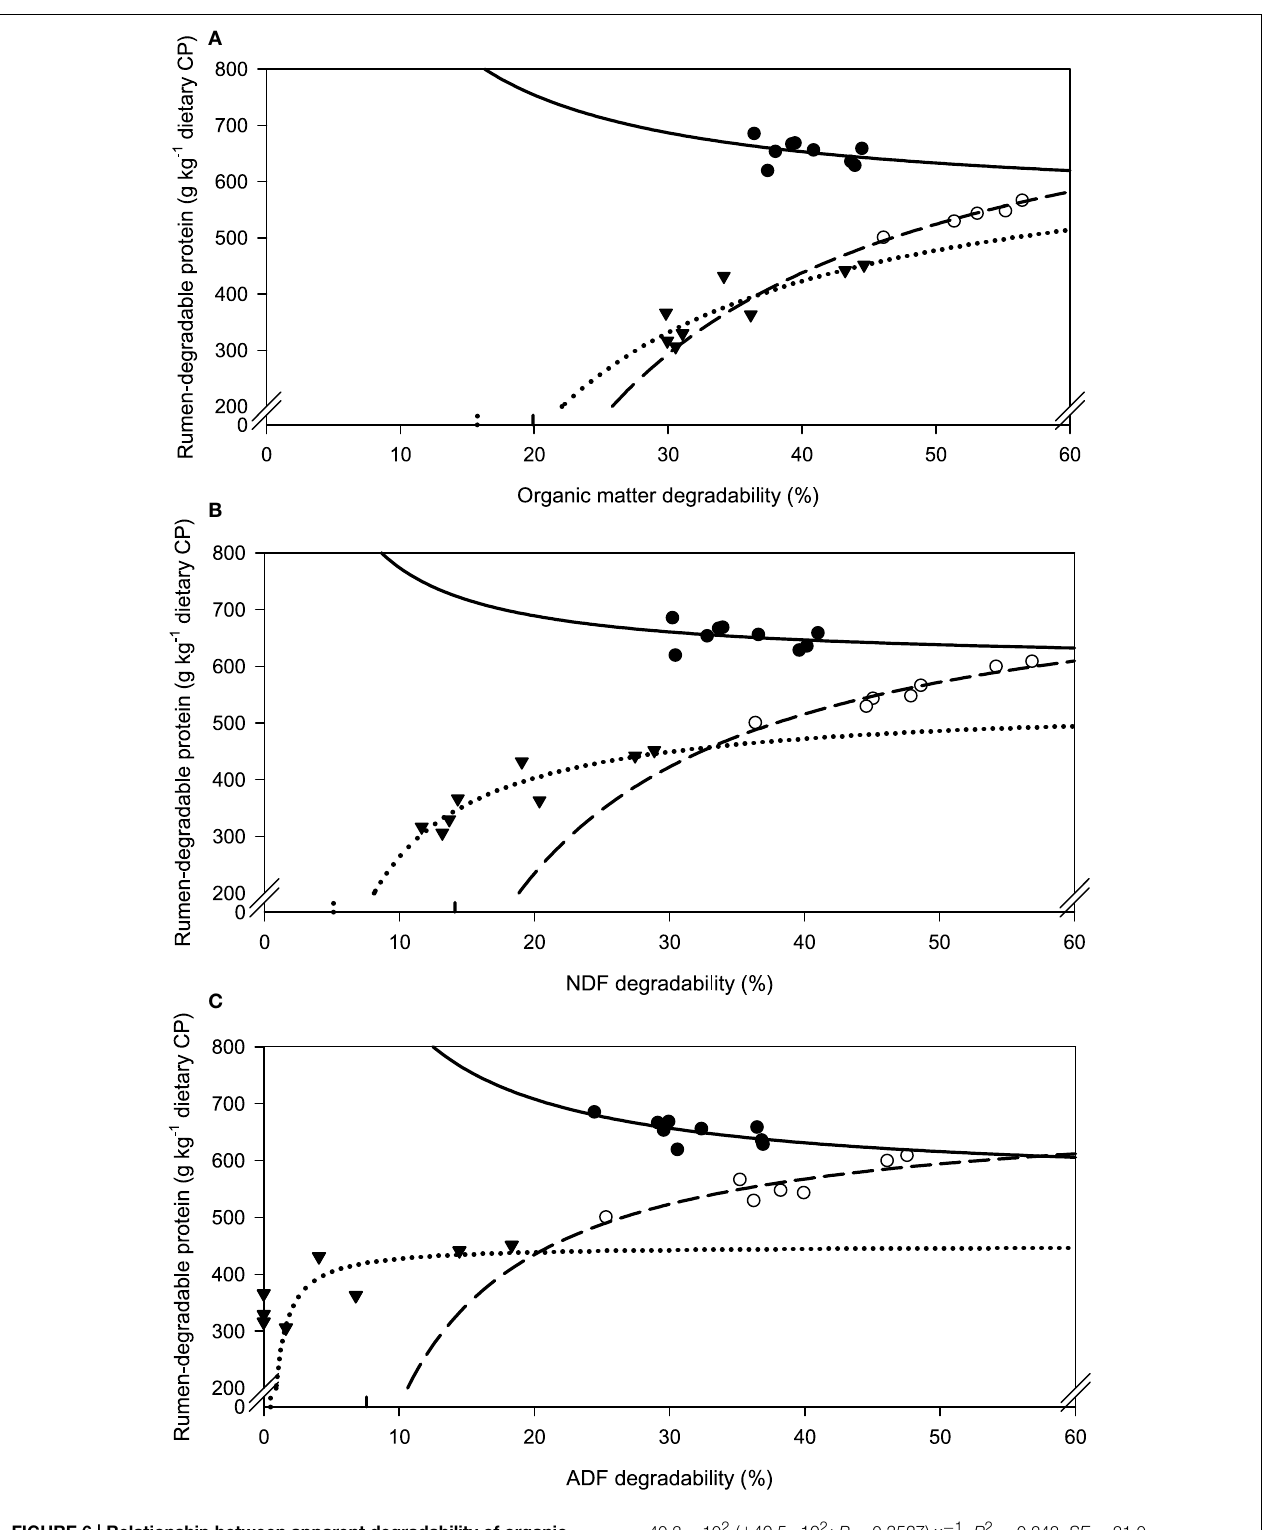
40 . 3 × 10 2 ( ± 40.5 × 10 2 ; P = 0 .3527) x − 1 , R 2 = 0 . 242 , SE = 21 . 0 , P = 0 .3527, (B) y = 604 ( ± 66.3; P < 0 . 001 ) + 17 . 0 × 10 2 ( ± 23 . 03 × 10 2 ; P = 0 .4849) x − 1 , R 2 = 0 . 0721 , SE = 21 . 6 , P = 0 .485, (C) y = 555